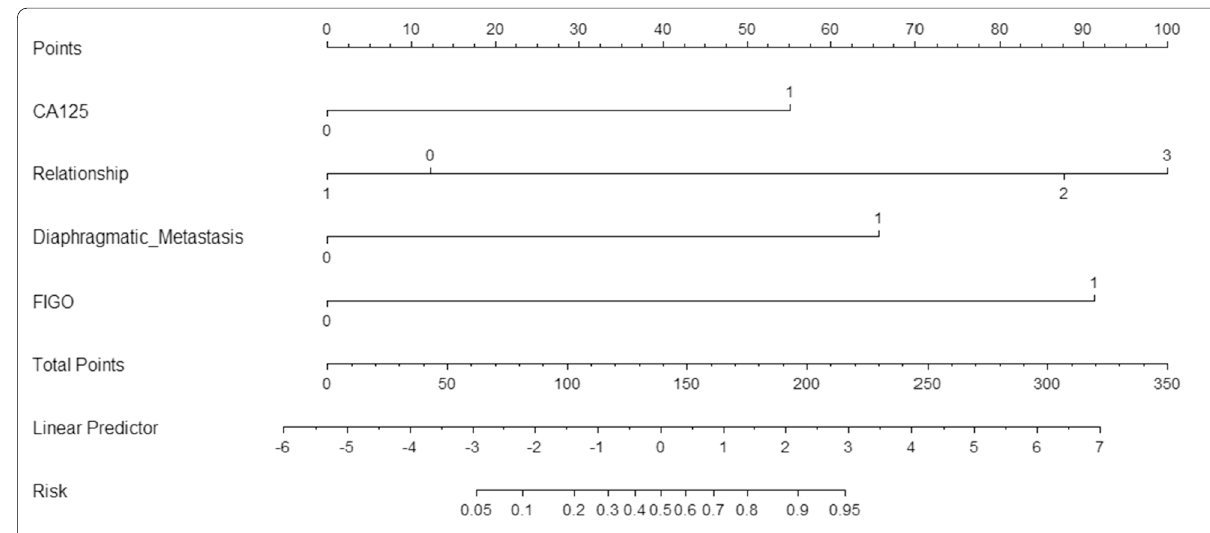
FIGO = International Federation of Gynecology and Obstetrics Fig. 3 Nomogram for the prediction of